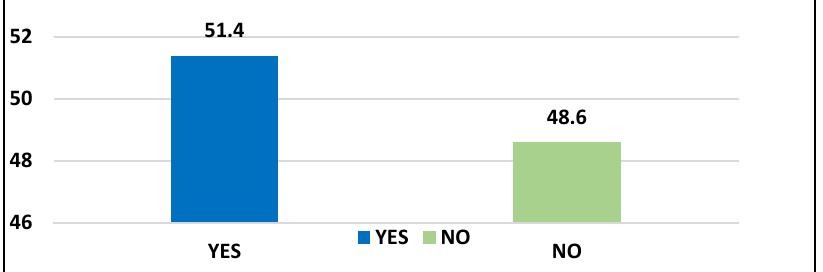
Figure 1. Respondents’ responses to students being treated as a clinical area workforce (N = 204).